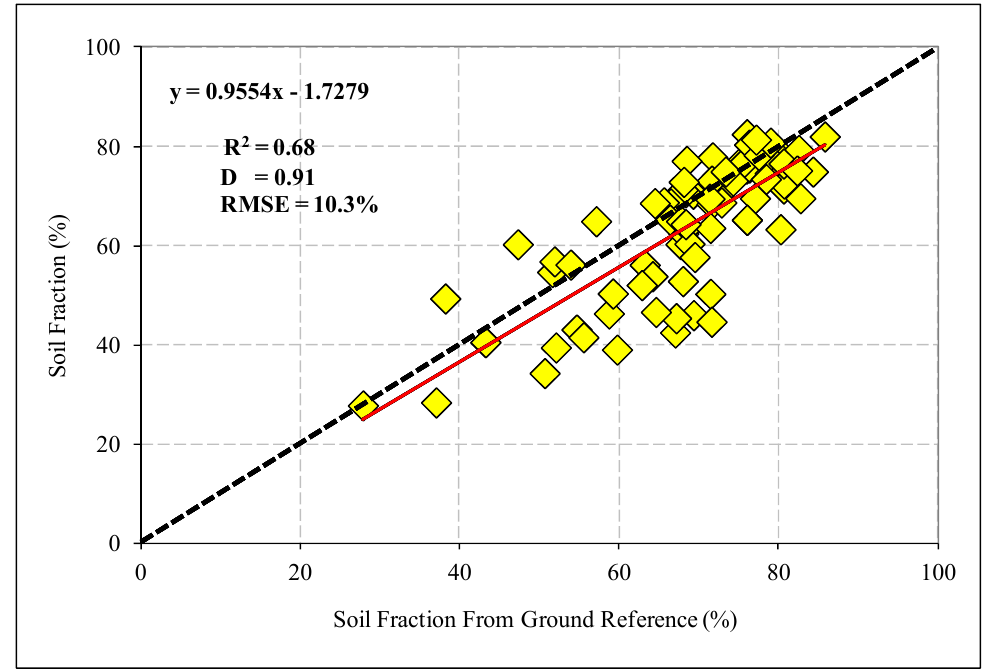
Figure 8. Relationship between percent soil cover (PSC) derived from Hyperion data and the ground reference measurements (PSC G ). The black line represents the 1:1 line and the red one indicates the regression